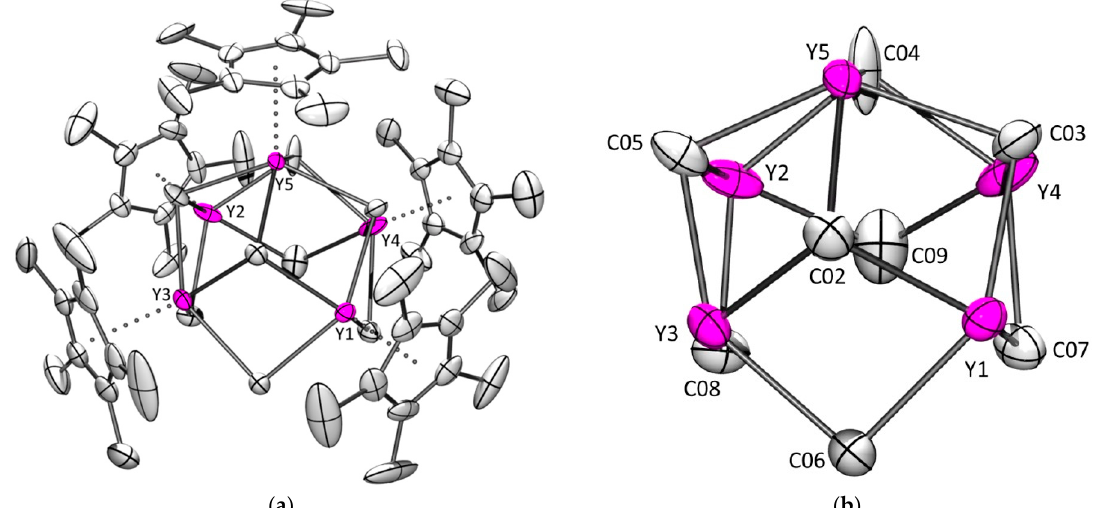
Figure 7. ORTEP view of the crystal structure ( a ) and detailed view on the bonding situation in the core structure (b) of [(Cp*Y) 5 (Me) 6 (CH 2 ) 2 ] ( 5 Y ). Atomic displacement parameters are set at the 30% ( a ) and the 50% ( b ) probability level. Hydrogen atoms and one molecule of toluene per asymmetric unit are omitted for clarity. See Table 7 for significant bond lengths and angles.